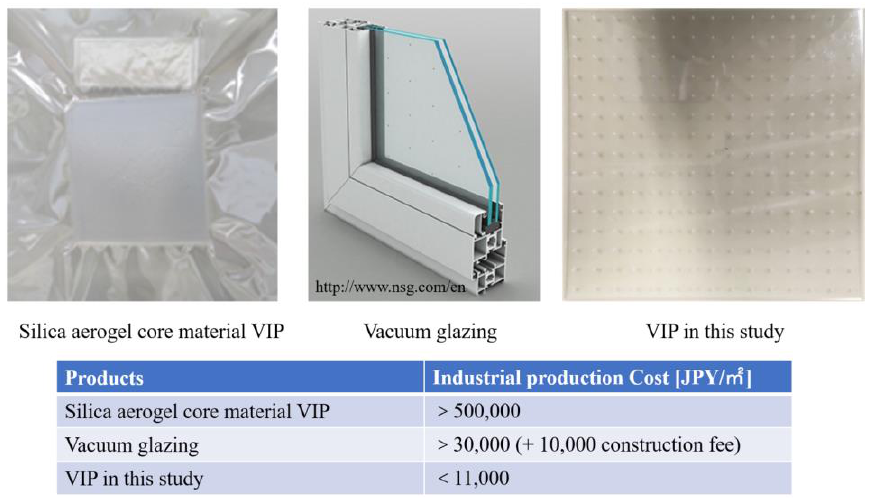
Figure 10. Industrial manufacture cost of transparent evacuated insulation products.